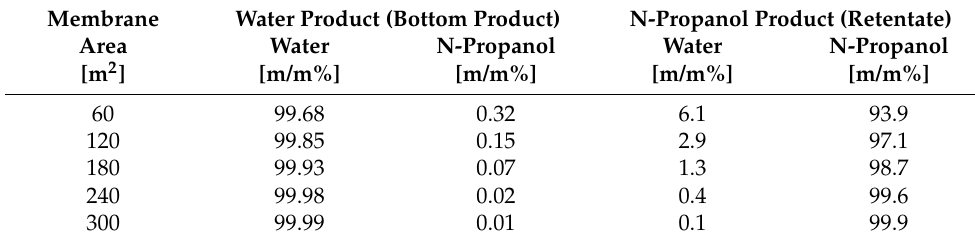
Table 5. Composition of Water- and N-propanol products in the function of membrane area. Membrane Water Product (Bottom